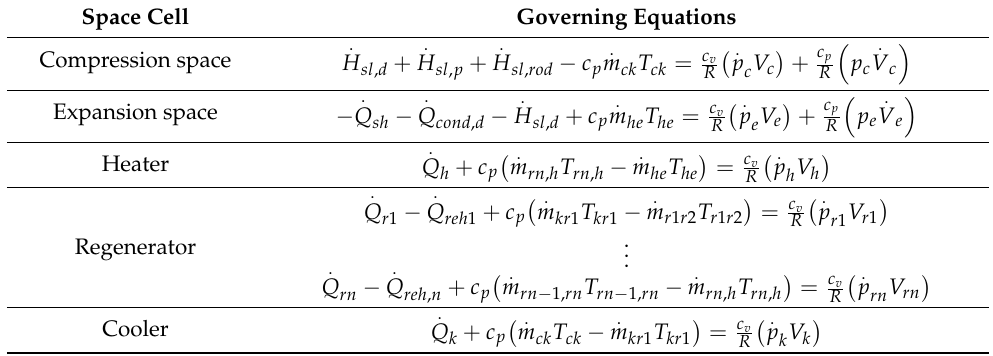
Table 5. Governing equations of space cells for the iQSF model (here, i = c , k , r , h , e , and j = p , d , rod ). Space